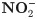
Comparison of measured and simulated NO2− accumulation assuming definitive versus stochastic initiation of nar transcription.To test the assumption of a single homogeneous population with almost all cells expressing nar in response to O2 depletion, we forced our model to achieve 98% Nar-positive cells (ZNa) within an hour by setting the specific-probability of initiating nar transcription (rNa) = 4 h-1. This resulted in grossly overestimated rates of NO2− accumulation for all treatments (grey curves). In contrast, we simulated the model with rNa = 0.035 h-1 obtained through optimisation, resulting in a reasonable agreement with measurements for all treatments (except for an apparent time frameshift for the Butyrate, 7% O2 treatment).